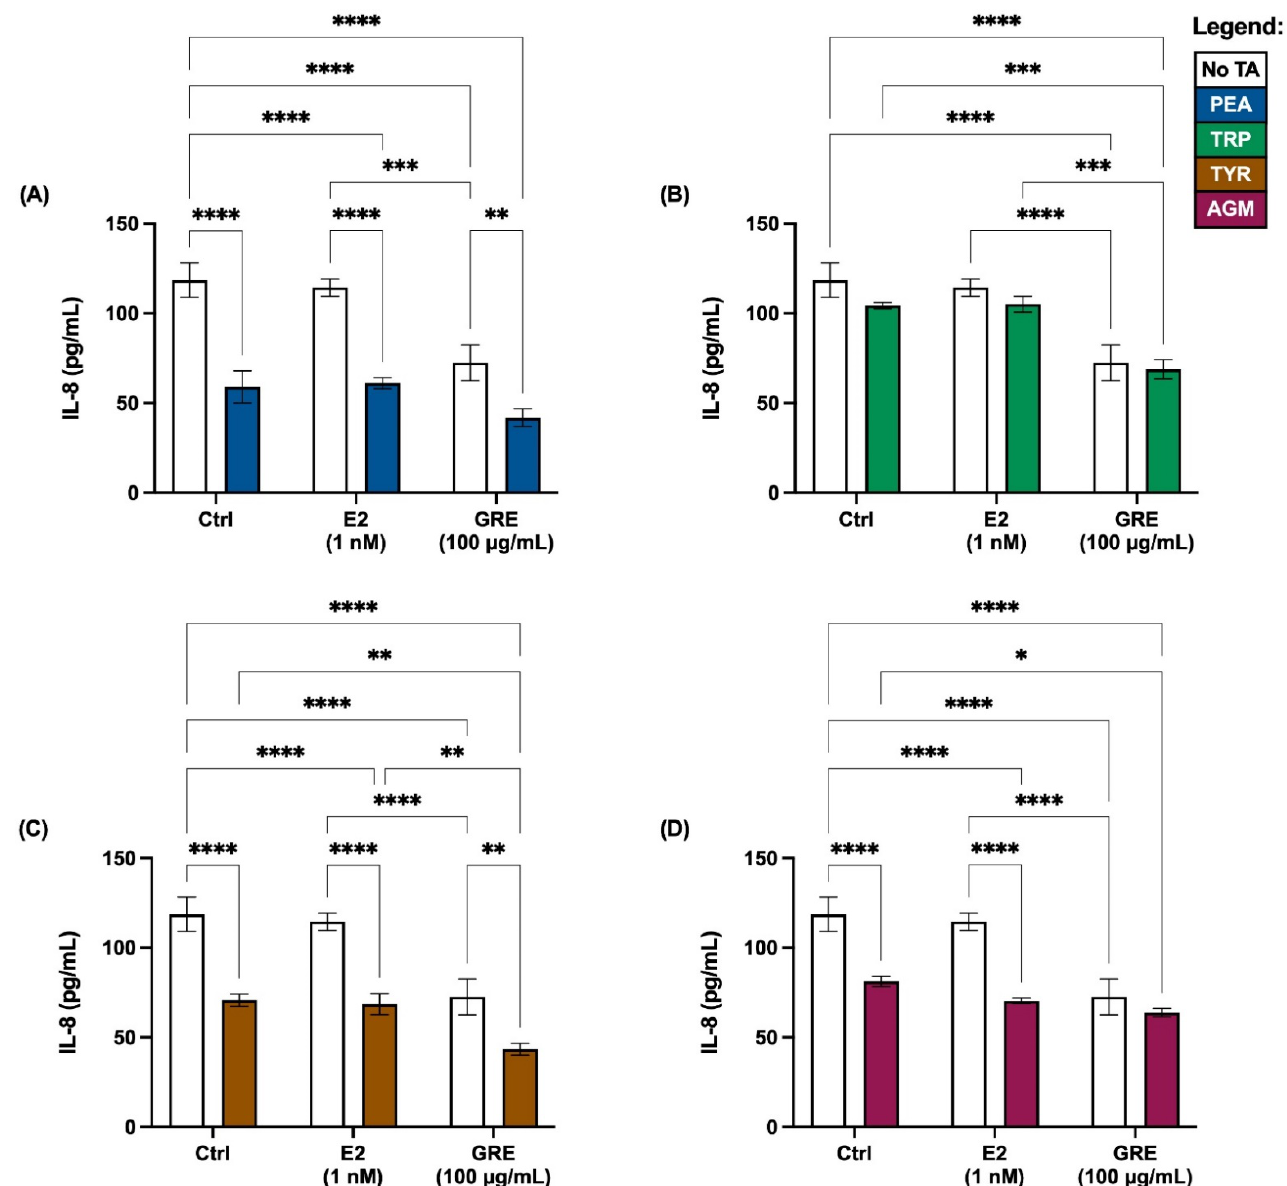
Figure 4. Effects of green rooibos extract (GRE) and estradiol (E2) on the concentration of interleukin-8 (IL-8) secreted by HT-29 cell monolayers following selected TA-exposure (200 ng/mL): ( A ) β -phenethylamine (PEA), ( B ) tryptamine (TRP), ( C ) ρ -tyramine (TYR) and ( D ) agmatine (AGM). The data are represented at mean ± SD, n = 3. Statistical analysis: 2-way ANOVAs with Tukey’s multiple comparison tests: * = p < 0.05, ** = p < 0.01, *** = p < 0.001, **** = p < 0.0001.